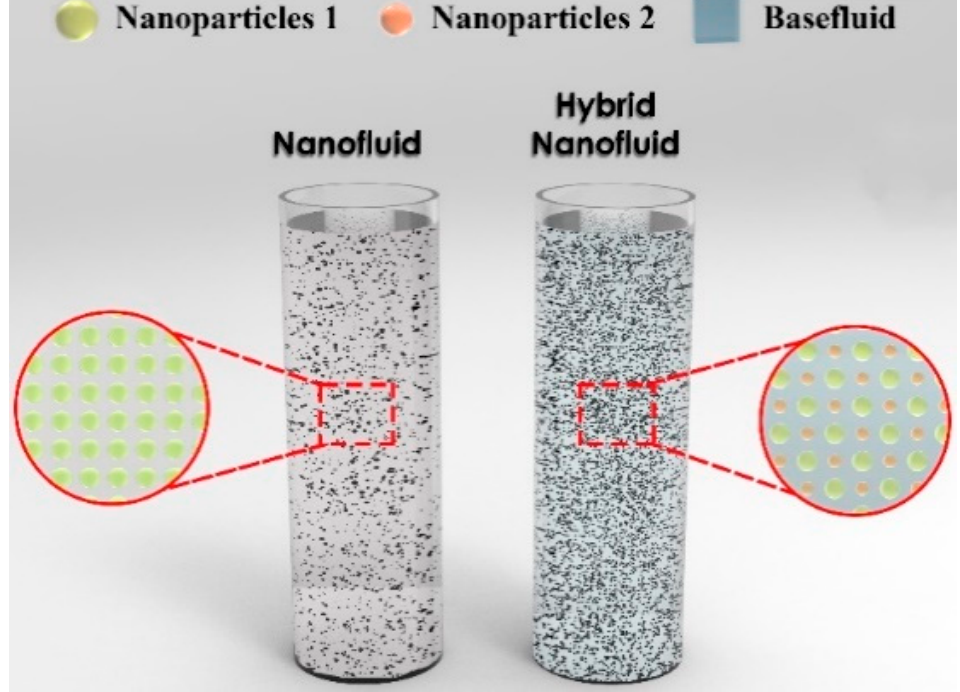
Figure 5. The two categories of nanofluids, where ( the left side ) exemplifies the conventional type of nanofluids, and ( the right side ) demonstrates the hybrid class of nanofluids.